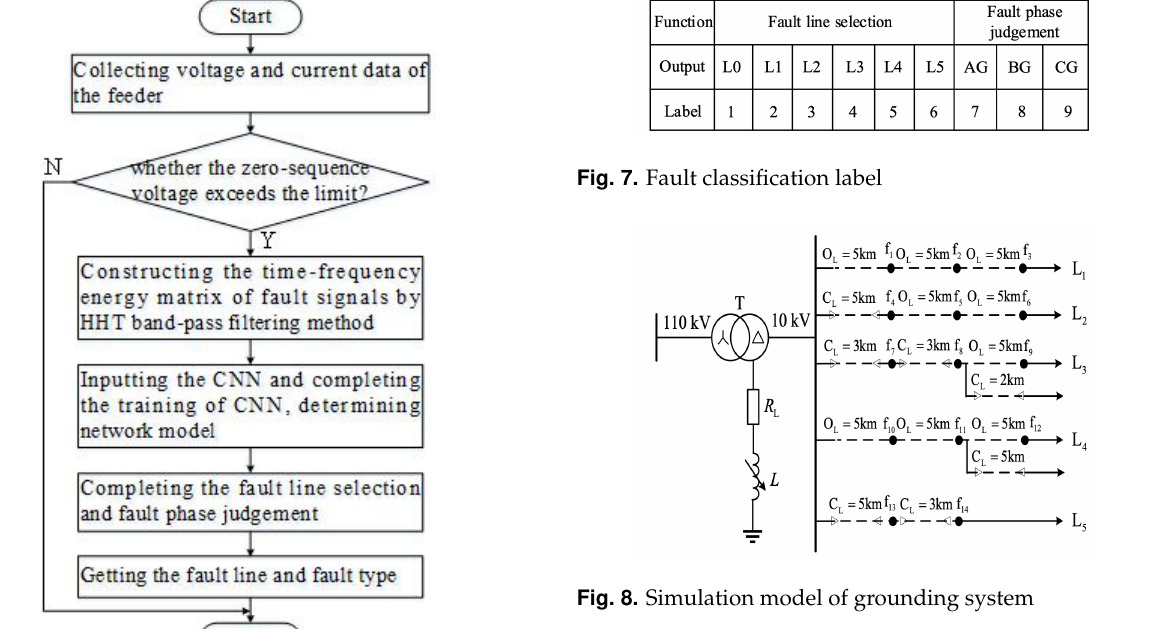
label 1 represents bus-bar fault, label 2~6 represent five faulty lines, and label 7~9 represent three single-phase grounding faults.